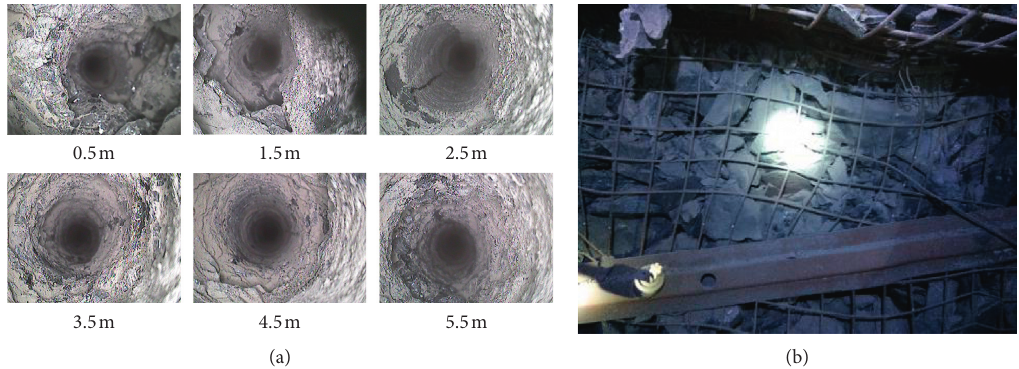
Figure 15: Roof fracturing effect: (a) development of internal fissures within the roof and (b) results of breaking the